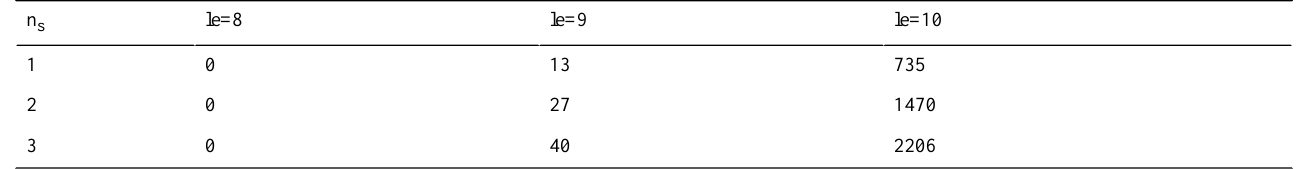
Table 4. Strength of improved PsychoPass method for different parameter settings (truncated to